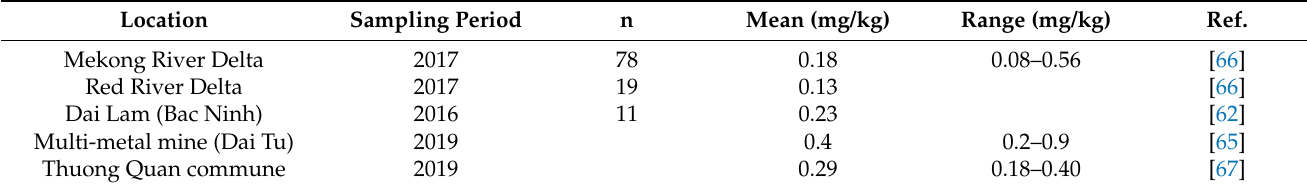
Table 4. Total arsenic concentration in polished rice from several regions in